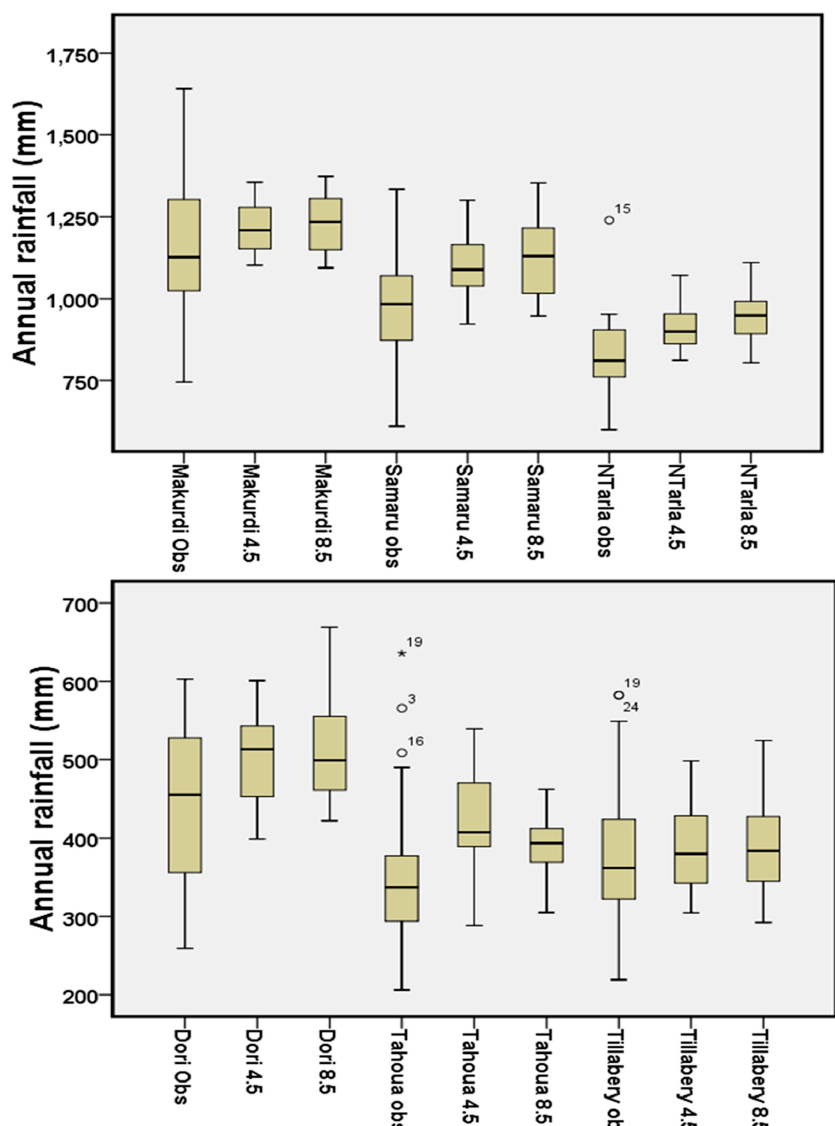
Figure 5. The Guinean (Makurdi, Samaru and N’Tarla) and Sahelian (Tahoua, Tillabery and Dori) agro-ecological zones average ensemble annual rainfall changes under the representative concentration pathway (RCP) 4.5 and 8.5 scenarios for the future period, 2021/2025–2050 relative to the baseline period, 1976/1980–2005. Note, all are statistically significant at 0.05. Table 3. Change in the seasonal rainfall for the Niger River Basin for the future period (2021/2025– 2050) relative to the historical period (1976/1980–2005).